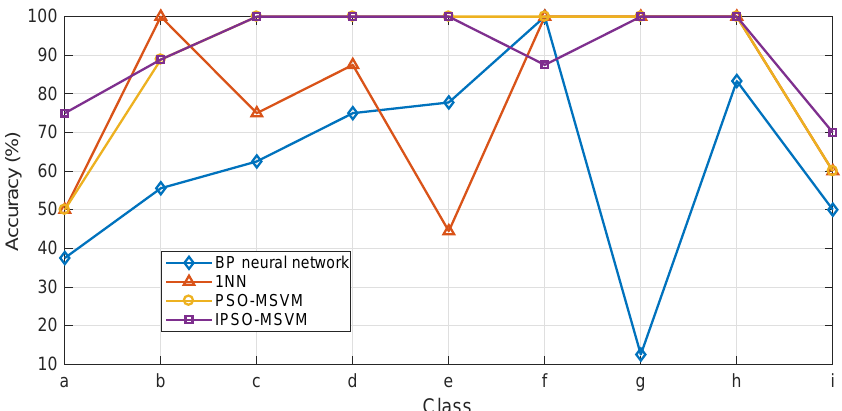
Figure 11. The identification accuracy of each class using different